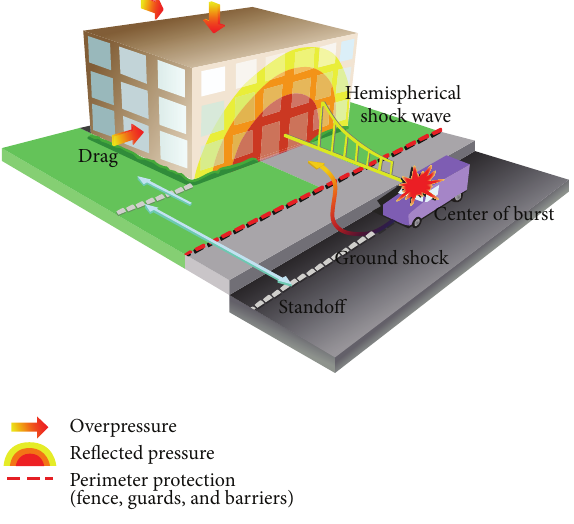
Figure 2: Schematic of a blast load